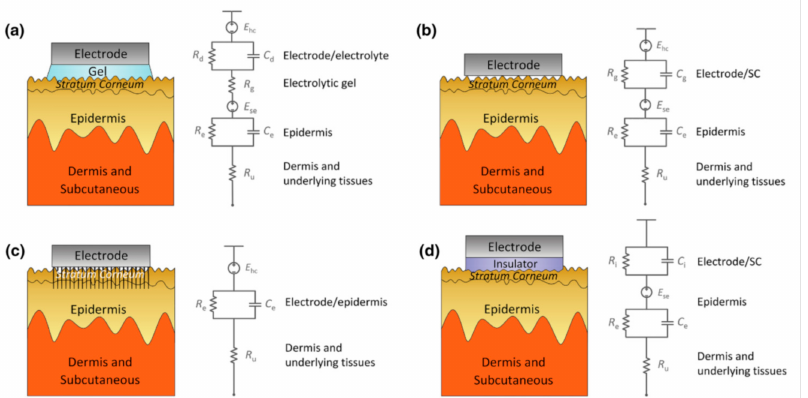
Figure 5. Schematics and corresponding electrode–skin interface models for EEG electrodes. ( a ) Wet electrodes, ( b ) MEMS electrodes, ( c ) non-contacted electrodes, and ( d ) common-contact dry electrodes